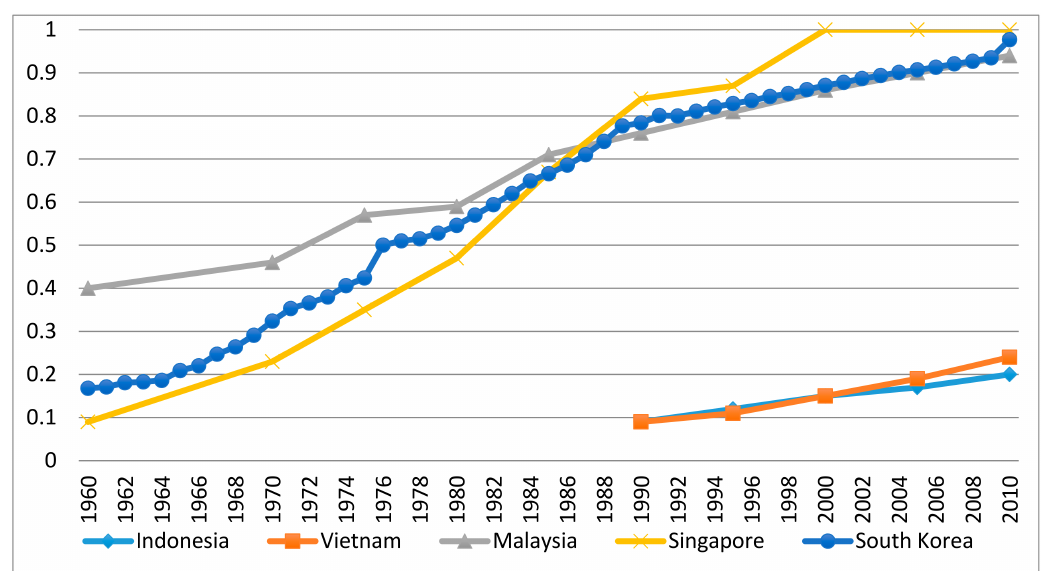
Figure 2. Percentage of National Population with Access to Piped Water onto Premises. Sources: (UNICEF and WHO 2013a, 2013b); 5-Year Development Plans of Malaysia dating back to 1955 and up to 2010. This includes the 1st and 2nd Malaya Development Plan and 1st to 7th Malaysia Development Plans. All published by the Malaysia Government. The figure after 1990 come from (UNICEF and WHO 2013c). They were adopted, as they were more conservative figures; Housing and Development Board (2014). HDB Annual Report 2013/2014. Singapore: Housing & Development Board; Ministry of Environment (2008). ᄉ ᅢ ᆼ ᄒ ᅪ ᆯ 에서 ᄉ ᅢ ᆼᄆ ᅧ ᆼ 까지 맑 은 물 로 지켜 ᄋ ᅩ ᆫ 100 ᄂ ᅧ ᆫ : ᄒ ᅡ ᆫ 국 ᄉ ᅡ ᆼ 수도 ᄇ ᅢ ᆨᄂ ᅧ ᆫ 사 지 ᄇ ᅡ ᆼ ᄀ ᅪ ᆼ 역 ᄉ ᅡ ᆼ 수도 ᄑ ᅧ ᆫ . Seoul, South Korea: Ministry of